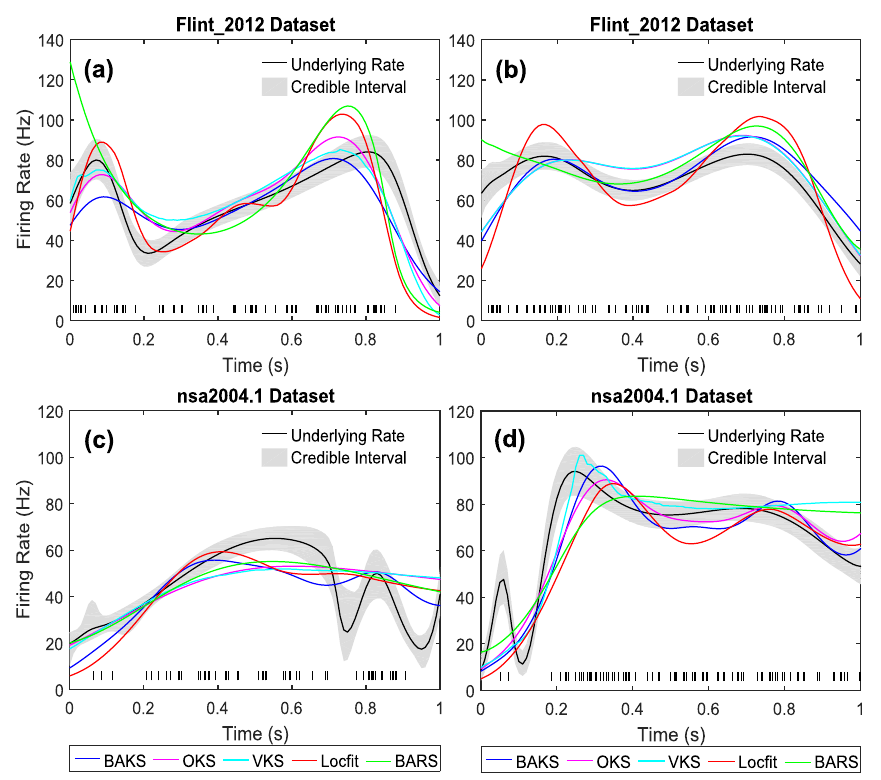
Fig 12. Firing rate estimates comparison for real neural data. (a) Firing rate estimates from ‘N184’ of Flint_2012 dataset (b) Firing rate estimates from ‘E164’ of Flint_2012 dataset (c) Firing rate estimates from ‘j032_25.6’ of nsa2004.1 dataset. (d) Firing rate estimates from ‘j032_51.2’ of nsa2004.1 dataset. Black lines and gray-shaded regions indicate the ‘true’ underlying rates and their 95% credible intervals, respectively. Black raster in the bottom of each plot represents a single spike train generated from the associated underlying